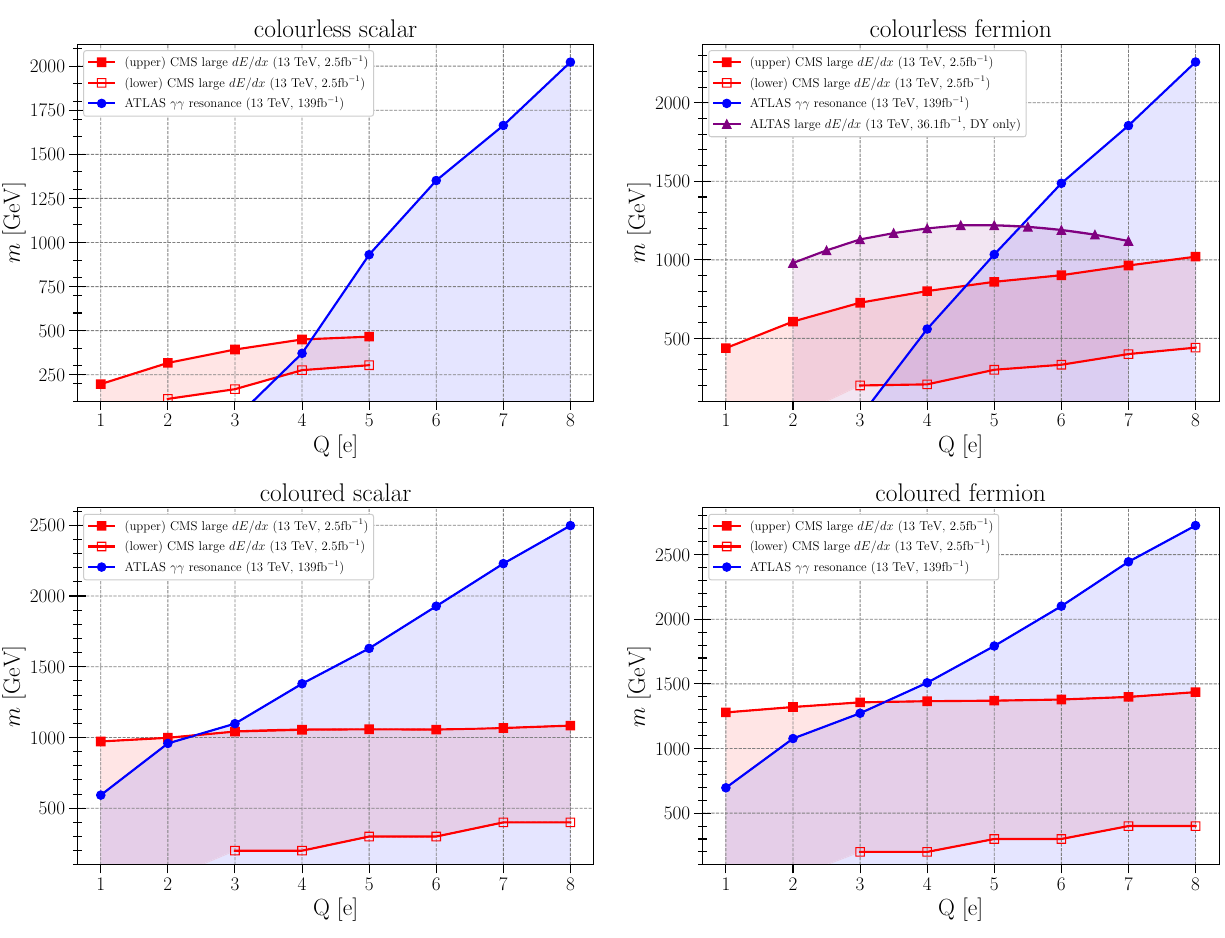
Fig. 11 The mass limits on the multi-charged LLPs: colourless scalars (top left), colourless fermions (top right), coloured scalars (bottom left) and coloured fermions (bottom right); recasted to take into considera- tion photon-induced production processes. The region between the two red curves is excluded by the large dE / dx analysis with the 13 TeV